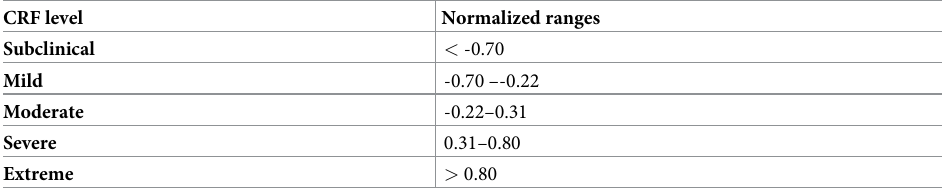
Table 4. Cancer-related fatigue classification